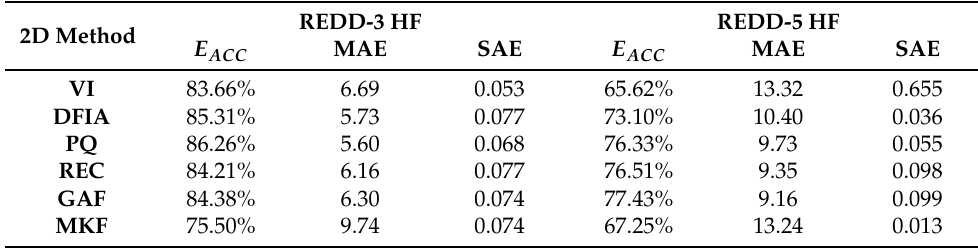
Table 4. Results for protocols #1 in terms of E ACC , MAE, and SAE for the high-frequency data of REDD-3/5.